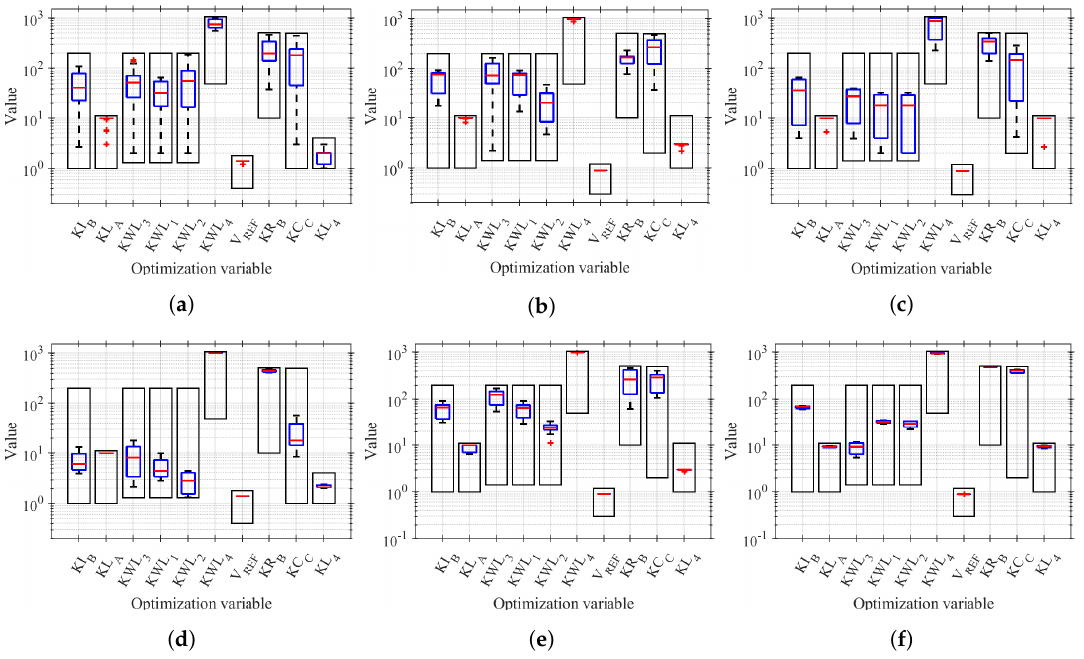
Figure 12. Values of the optimization variables of the solutions in the Pareto front obtained with: ( a ) SQP-180 nm, ( b ) SQP-130 nm, ( c ) SQP-65 nm, ( d ) NSGA-II-180 nm, ( e ) NSGA-II-130 nm and ( f ) NSGA-II-65 nm.